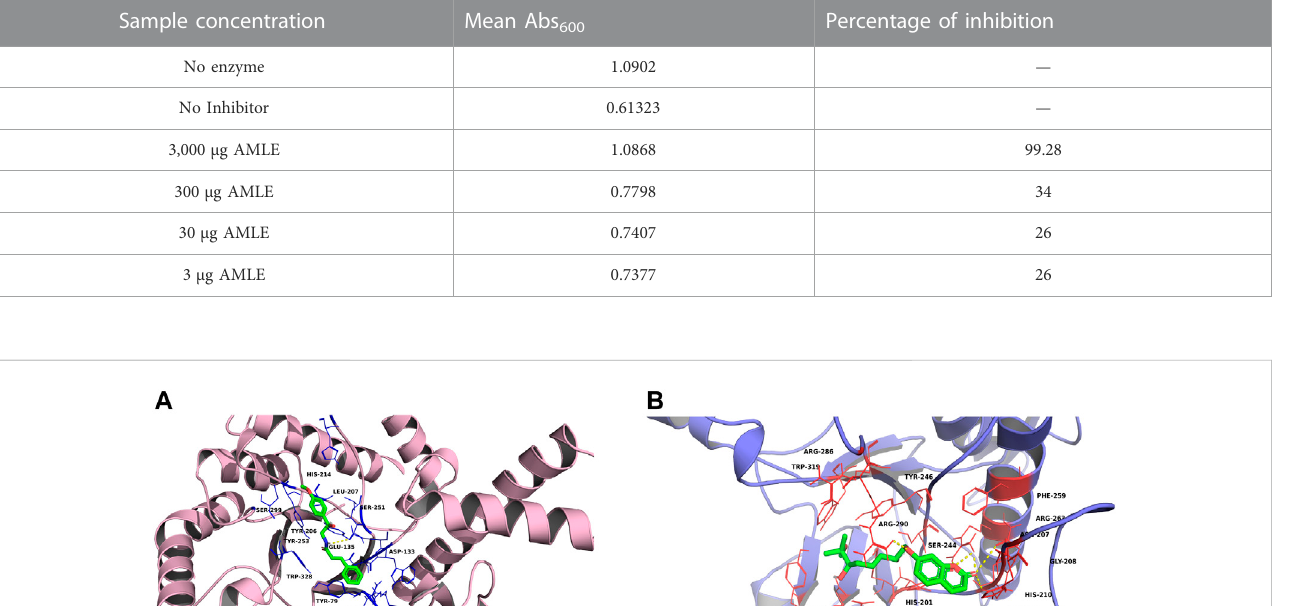
TABLE 4 Results of Hyaluronidase inhibition assay for AMLE.